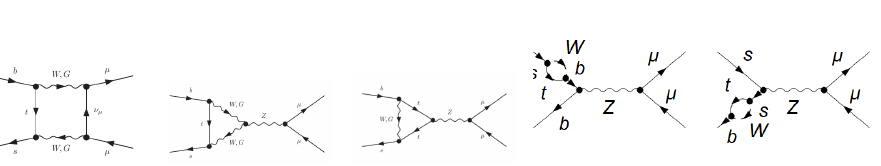
Figure 2: Major contributions to the B 0 diagrams, Z-Penguin diagrams, Self-energy